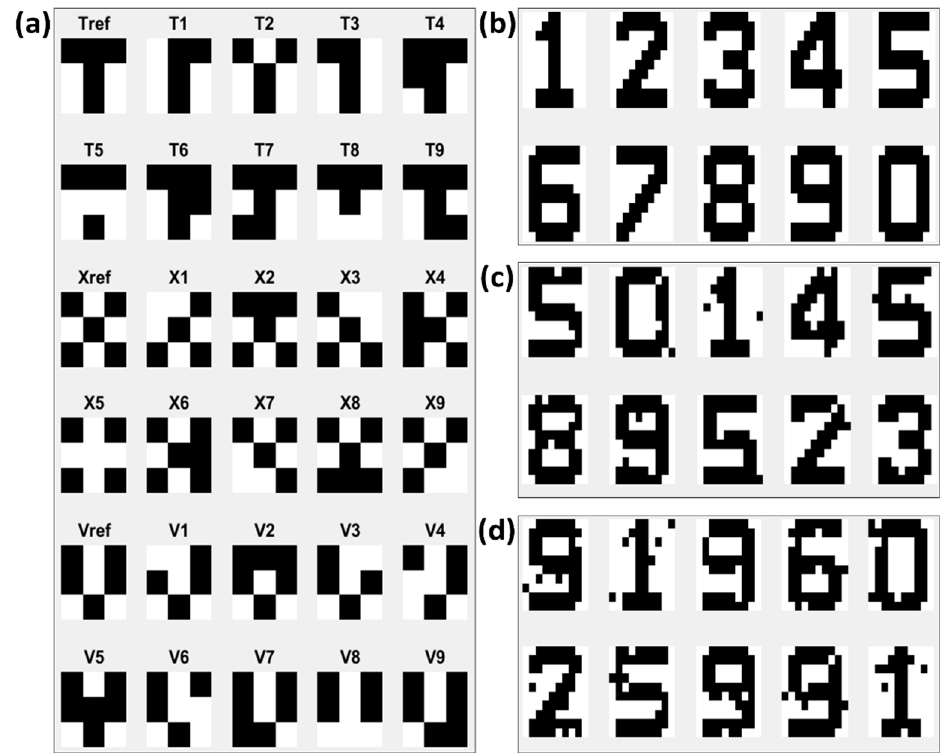
6 of 12 Table 3. Guide training